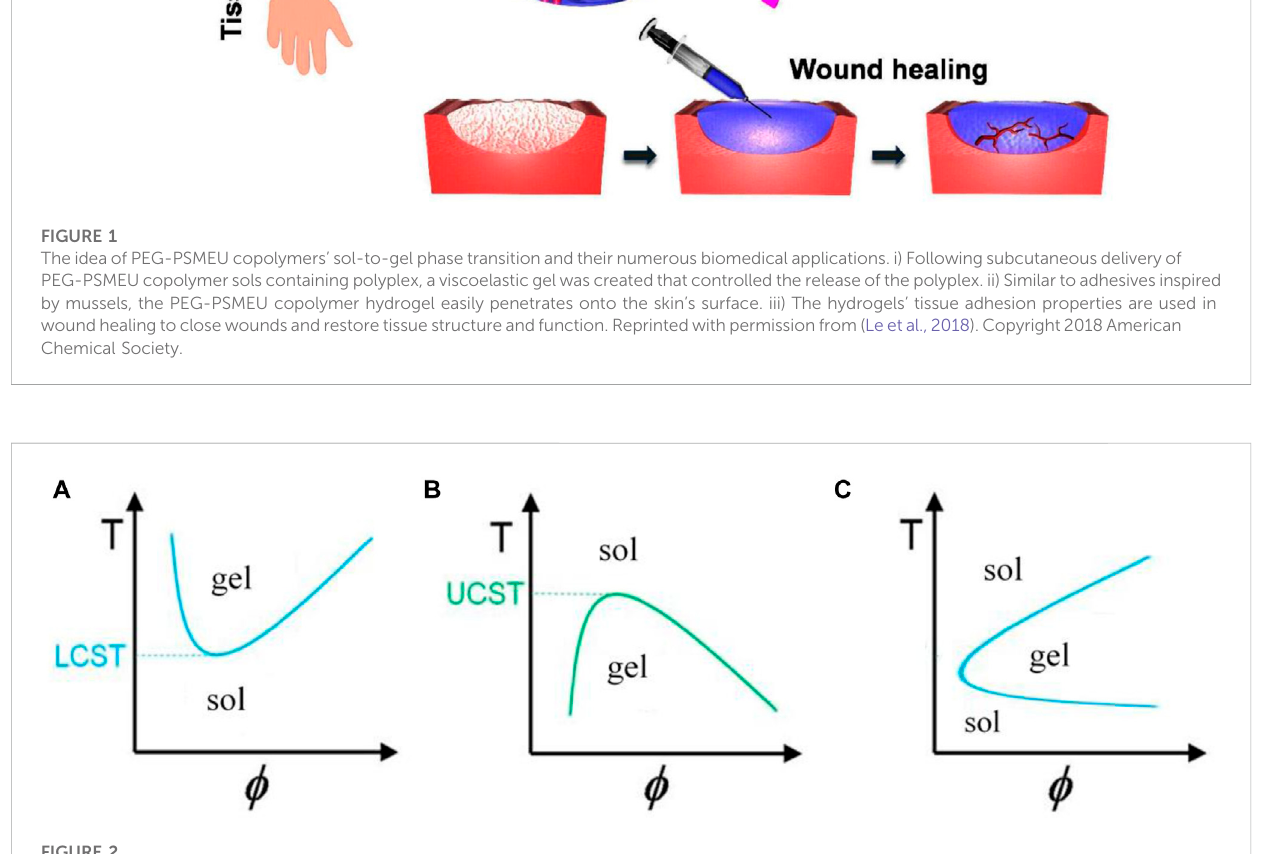
FIGURE 2 Graph oftemperature changeswith volume fractionofpolymerinsolutionfor gels with (A) negative, (B) positive (Wardand Georgiou, 2011),and (C) reversible temperature